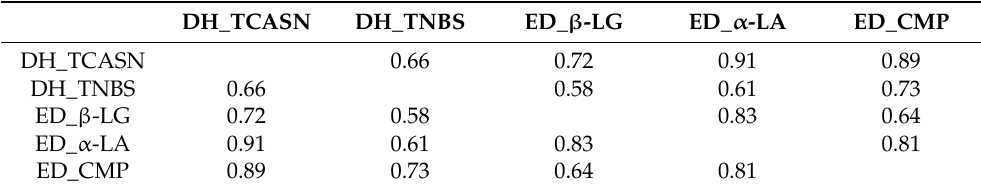
Table 5. Correlation coefficients between the hydrolysis indices of Table 4. as Abbreviations explained in Section 2.2.2 and Table